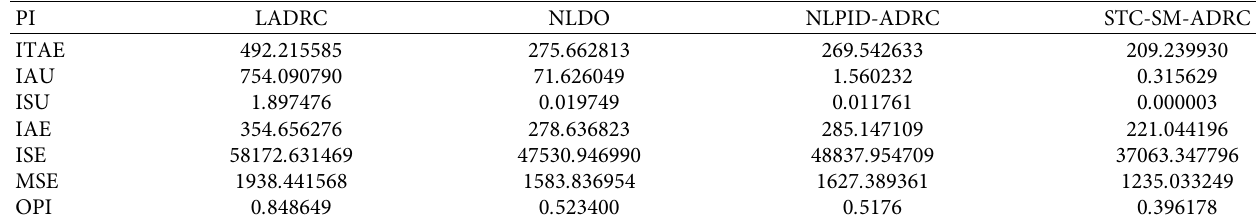
Table 11: Performance